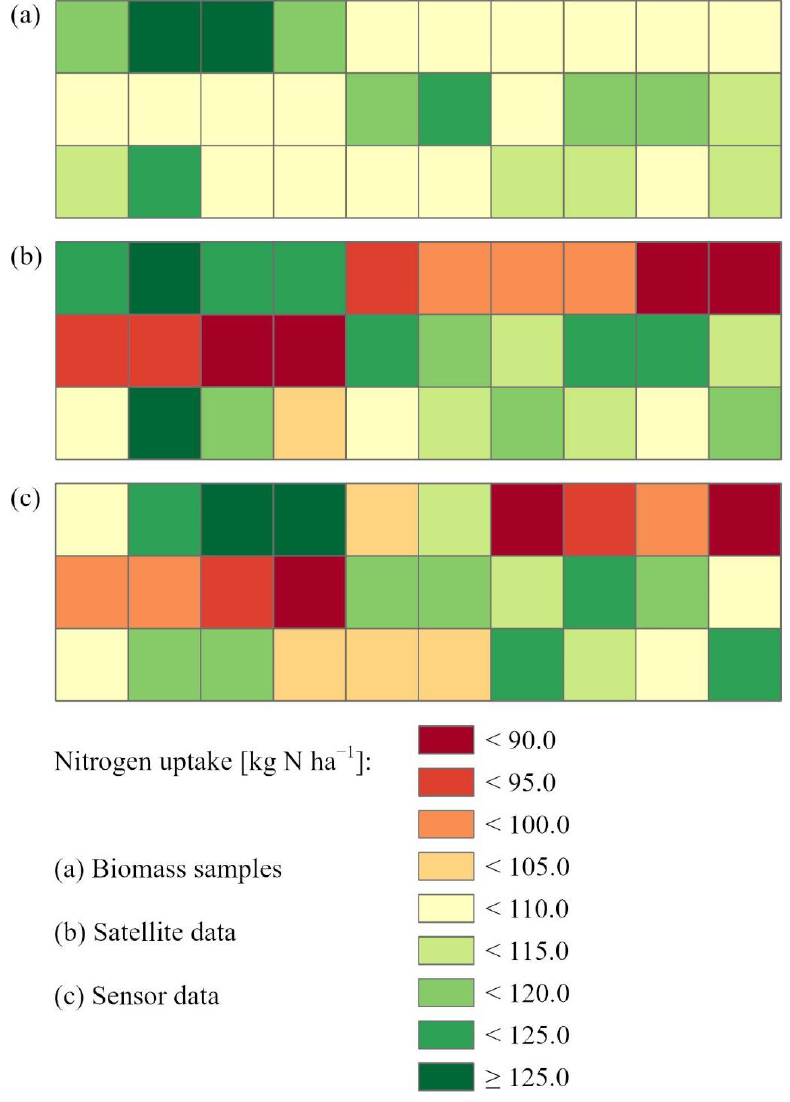
Figure 3. Nitrogen uptake 2020, BBCH 39. Nitrogen uptake was determined from the biomass samples, sensor data, and satellite data. Both the satellite and sensor data in BBCH 55 and 65 showed similar nitrogen distributions, which was consistent with the ground truth data. However, the absolute level of nitrogen uptake was noticeably lower with the satellite data than with the ground truth data, whereas it was higher with the sensor data. A deviation of −20% in the mean nitrogen uptake with the satellite data and +10% with the sensor data was observed in BBCH 55 and 65. Table 4. Descriptive statistics of the nitrogen uptake data in kg N ha −1 analyzed in this study. Variable